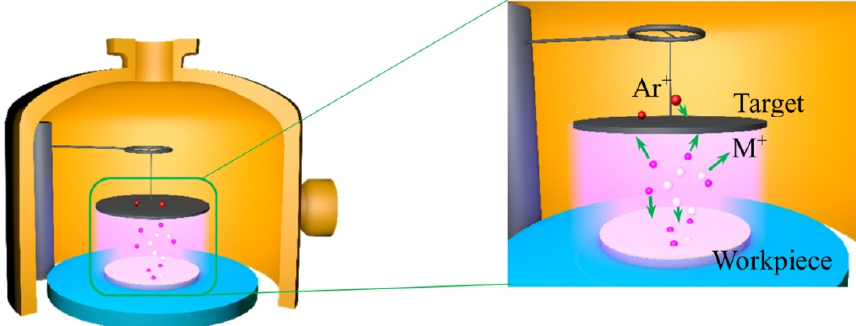
Figure 1. Schematic diagram of the DGPSA technology [1].